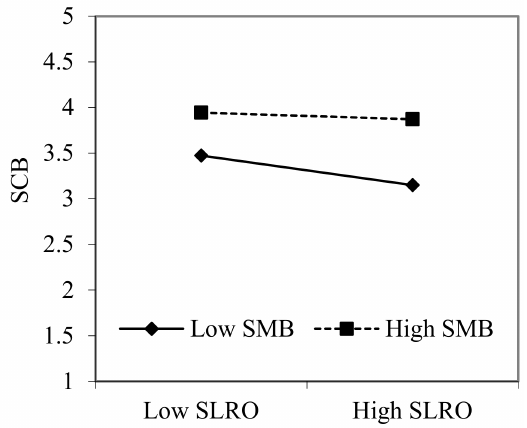
Figure 2. The interaction effect of SLRO and SMB on SCB. Note: SLRO, safety-specific leader reward omission, SLPO, safety-specific leader punishment omission, SMB, safety moral beliefs and SCB, safety compliance behavior.